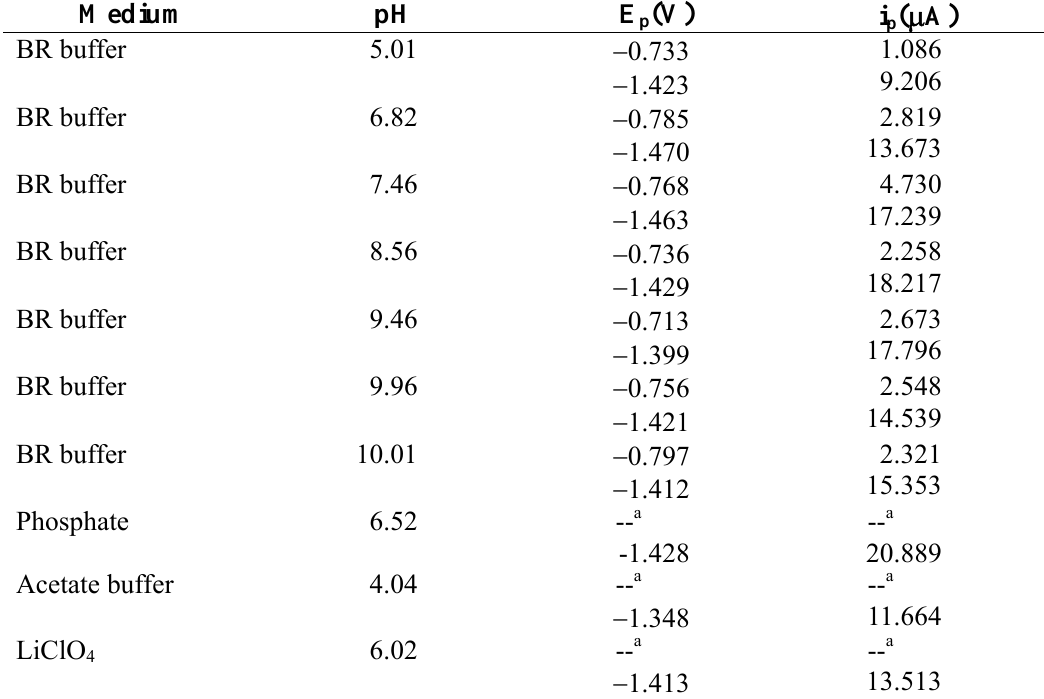
Table 1. The effect of pH and supporting electrolytes on the differential pulse voltammetric peak potential and peak current of coumarin at mercury-modified glassy carbon electrode